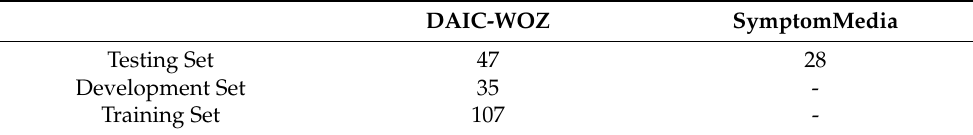
Table 4. The sizes of the datasets.